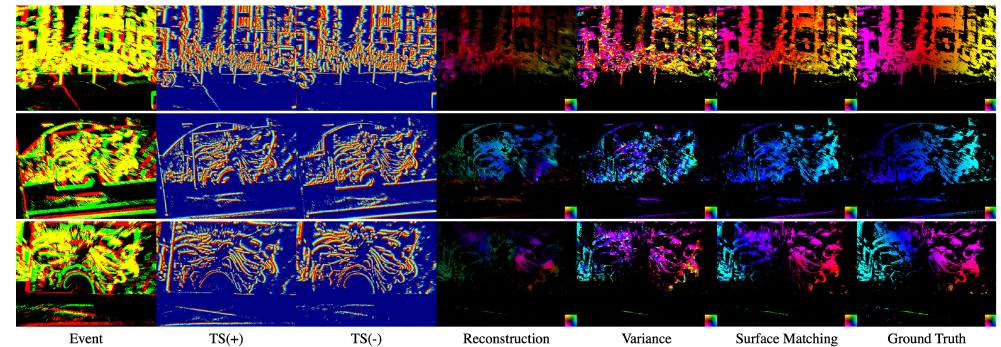
Figure 8. Qualitative results from HVGA Asynchronous Time-based Image Sensor (ATIS) Corner Dataset (HACD). Left to right: event data, positive time surface S + , negative time surface S − , the predicted optical flow by Reconstruction [9], Variance [10] and Surface Matching (ours). The red and green events indicate each polarity and yellow shows that both of them occur at the pixel. The time surfaces are colored with red for the most recent and blue for the oldest part of the time surface. Optical flow is colored by direction as the lower right colormap in each image.